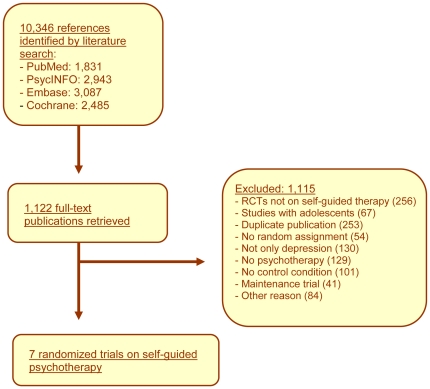
Flowchart of inclusion of studies.